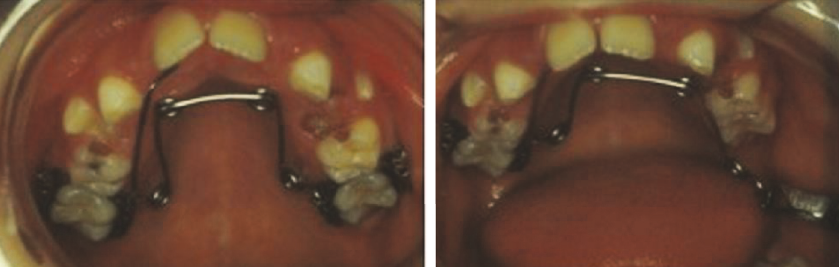
Figure 7: Application and activation system of the asymmetric Quad Helix; it can be seen that there is the absence of a torque control allowing the expression of a single force on tooth 2.6.